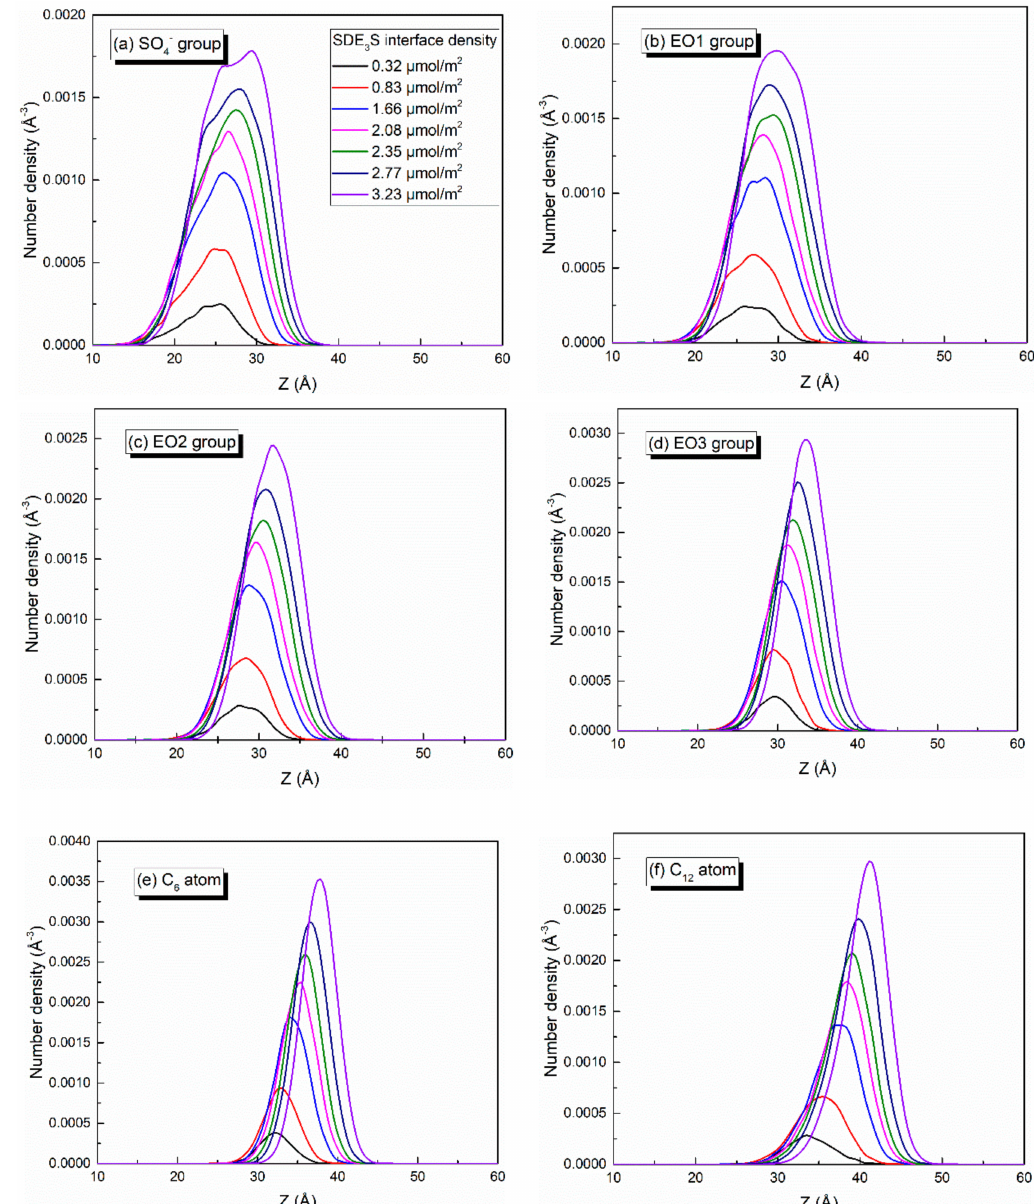
Figure 8. Number density profiles of ( a ) SO 4 − , ( b ) EO1, ( c ) EO2, ( d ) EO3, ( e ) C 6 , and ( f ) C 12 in SDE 3 S